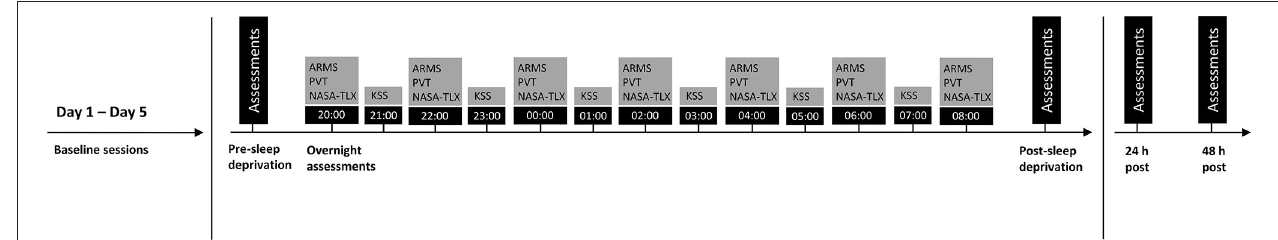
FIGURE 1 | Experimental protocol. Assessments, including the Acute Readiness Monitoring Scale (ARMS), biological markers of readiness (heart rate variability, saliva sample) and cognitive performance [psychomotor vigilance test (PVT)] were taken before (pre-sleep deprivation) and after (post-sleep deprivation, 24- and 48h post) sleep deprivation. Overnight assessments (from 20:00 to 08:00h) included the ARMS, PVT, National Aeronautics and Space Administration Task Load Index (NASA-TLX) and Karolinska Sleepiness Scale (KSS). These were collected in order of presentation (from left to right, top to